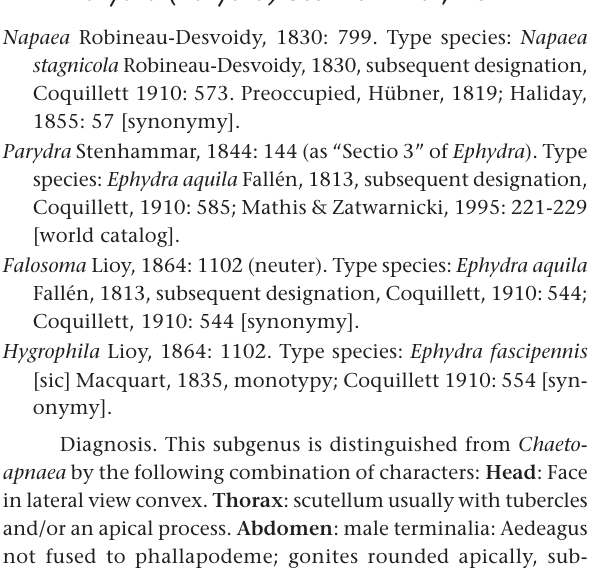
tio: 0.39-0.40; costal vein ratio: 0.60-0.71. Femora and tibiae black; tarsi blackish yellow, more yellowish ventrally. Abdomen : male terminalia (Figs 1-6): aedeagus and phallapodeme fused